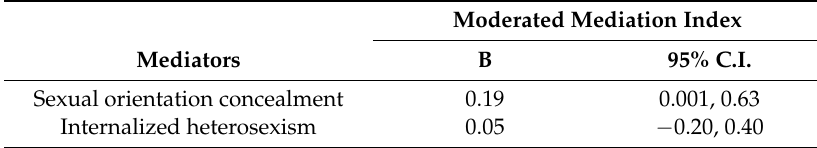
Table 4. Indirect effects of prejudice events on parenting desire through sexual orientation concealment and internalized heterosexism conditional on gender.